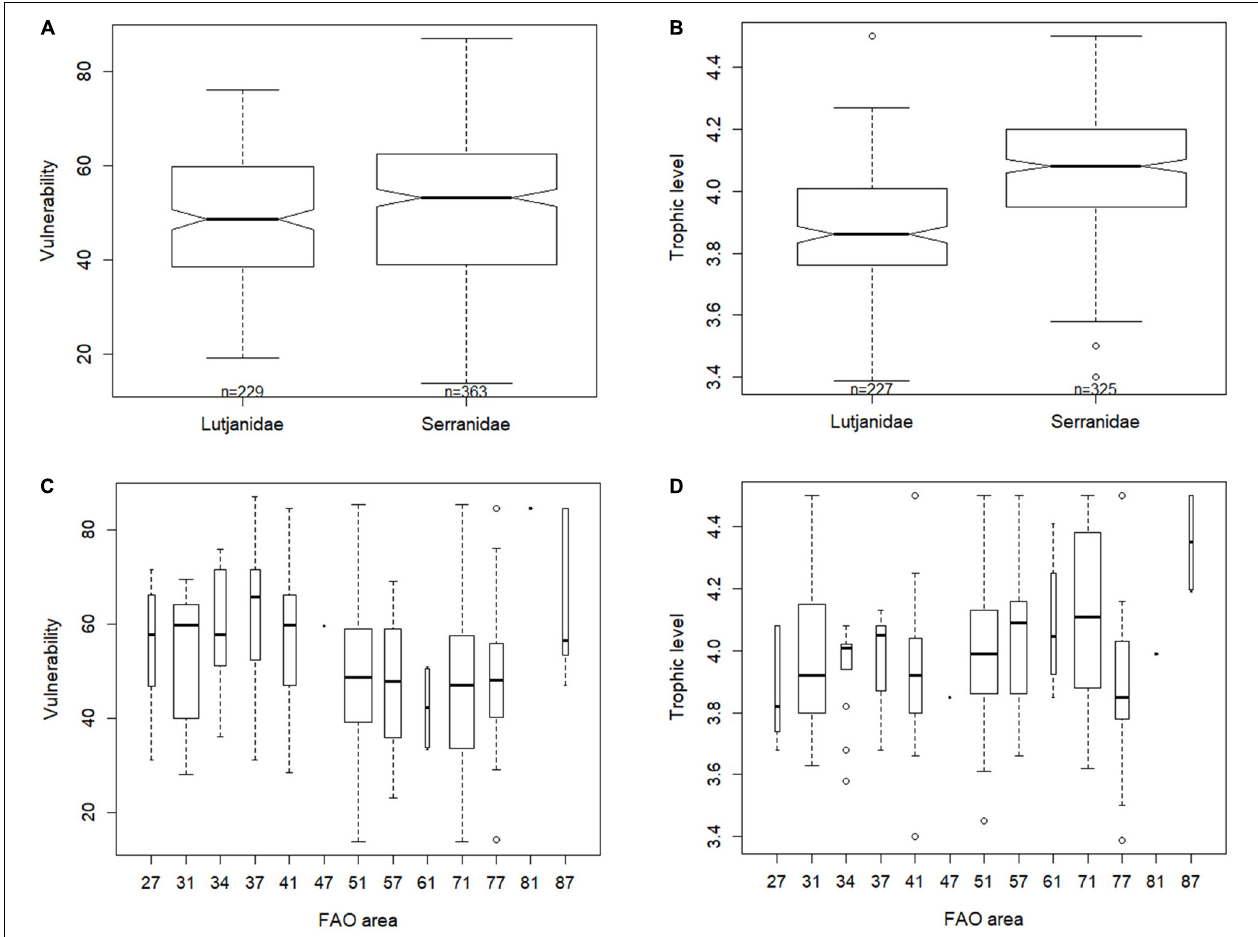
FIGURE 9 | Vulnerability and trophic level by family (A,B) (Lutjanidae and Serranidae) and FAO major fishing area (C,D) , considering the fisheries included in the database compiled for this study. FAO major fishing areas: 27, Northeast Atlantic; 31, Western Central Atlantic; 34, Eastern Central Atlantic; 37, Mediterranean;